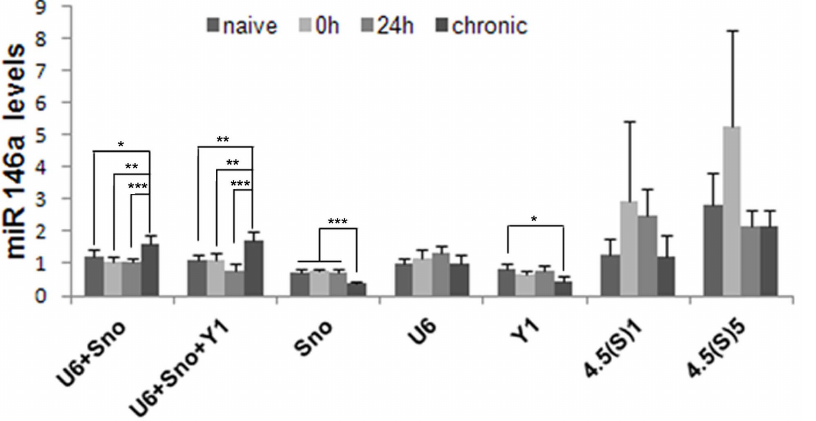
Figure 4. Relative quantities of miR-146a in the hippocampus of the systemic PILO- injected rats upon different normalization approaches. qRT-PCR data were normalized by single reference gene and best combination derived by geNorm or NormFinder analysis (mean + SD, n=6). The diagram shows mean levels of miR-146a transcripts in naive animals, epileptogenesis (0 h and 24 h) and chronic period. ANOVA, * P v 0 : 05 , ** P v 0 : 01 , *** P v 0 : 001